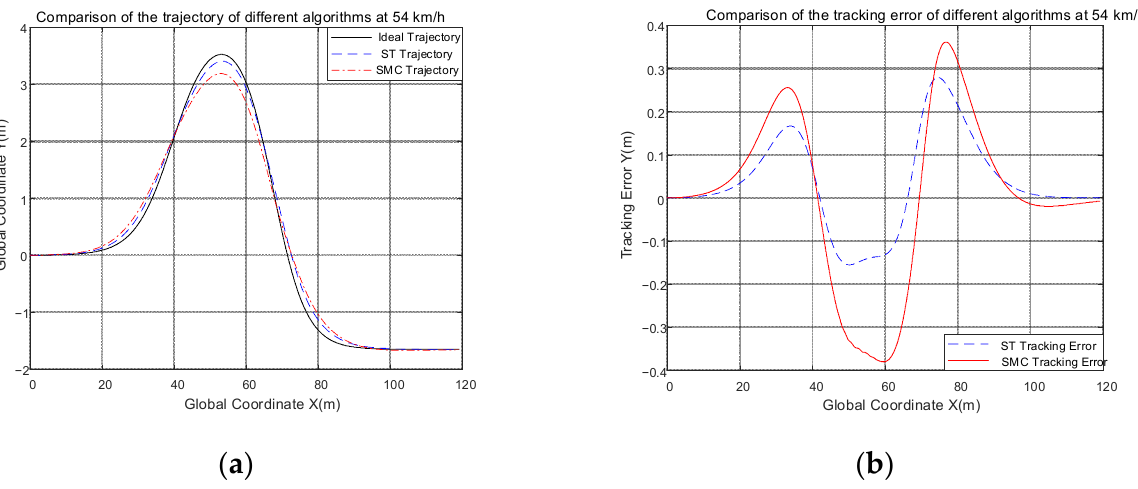
Figure 10. ( a ) Comparison of trajectories at 54 km/h; ( b ) comparison of the tracking error at 54 km/h.